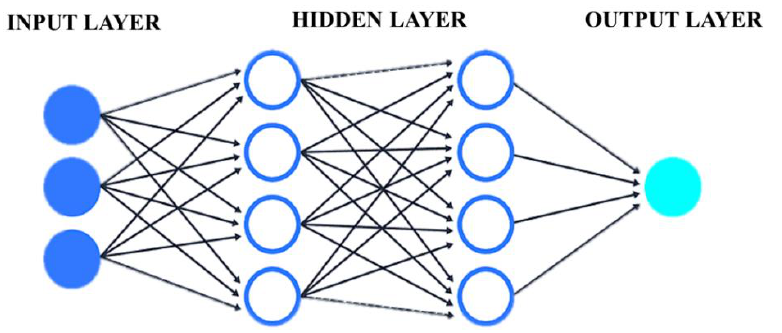
Figure 5. Artificial Neural Network.